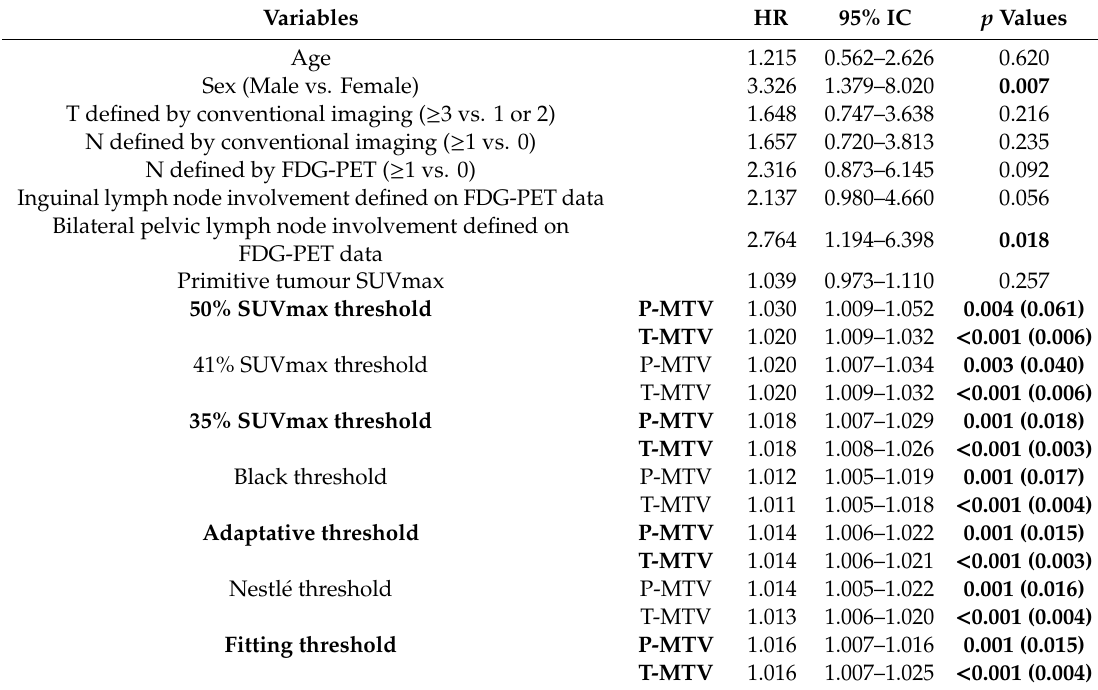
Table 2. Univariate